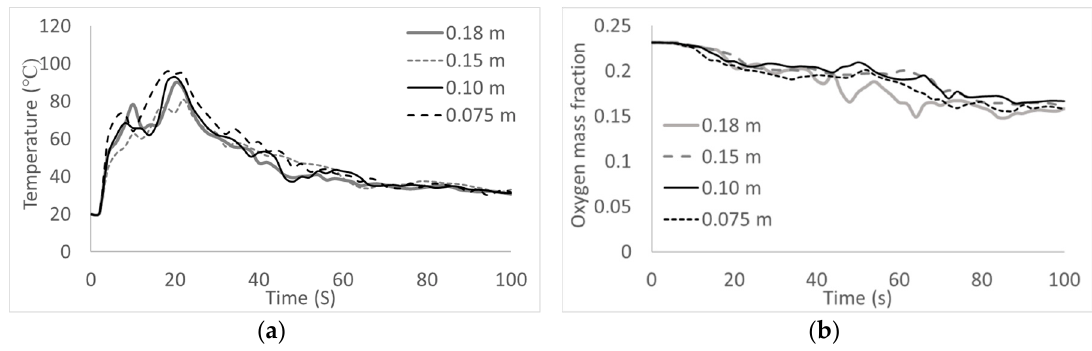
Figure 3. Predicted temperatures ( a ) and mass fraction versus time below the ceiling at the main room center from four mesh solutions ( b ).